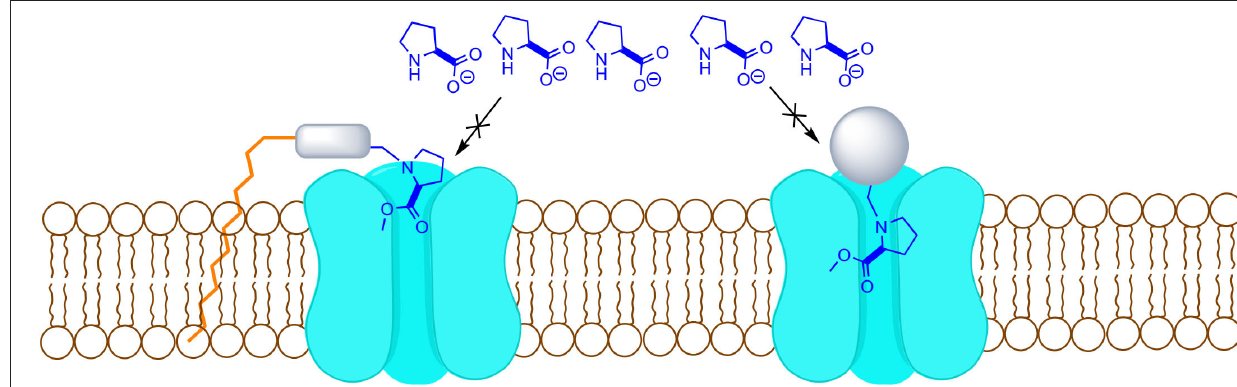
FIGURE 1 | Proposed model for transport inhibition.